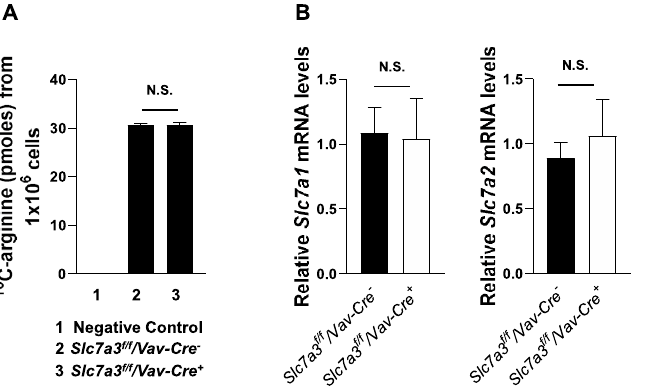
Figure 6. L-arginine uptake is not disrupted in Slc7a3 knockout cells. ( A ) BM Lin - cells freshly isolated from Slc7a3 f/f /Vav1-Cre − and Slc7a3 f/f /Vav1-Cre + mice (n = 3 mice/genotype) were starved in arginine-free SILAC RPMI 1640 medium for 2 h. 13 C labeled L-arginine was added to the culture systems. After 15 min of incubation, cells were collected and washed twice with pre-cooled PBS. Cell pallets (1 × 10 6 cells/sample) were processed for detection and quantification of 13 C-arginine by mass spectrometric analyses, as described in Materials and Methods. ( B ) BM Lin − cells were isolated from eight-week-old Slc7a3 f/f /Vav1-Cre − and Slc7a3 f/f / Vav1-Cre + mice (n = 3 mice/genotype). Total RNA was extracted, and Slc7a1 and Slc7a2 mRNA levels